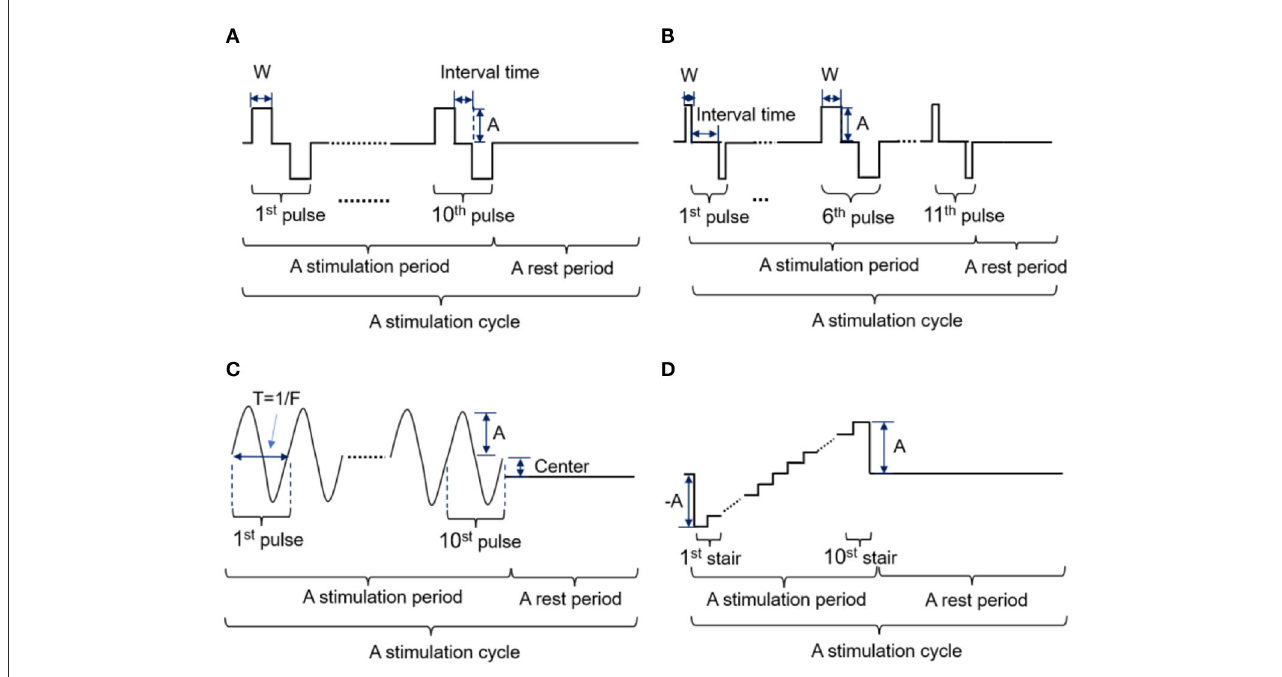
FIGURE2 (A-D) Four kinds of stimulation waveforms were tested in the selection experiment parameter ranges.